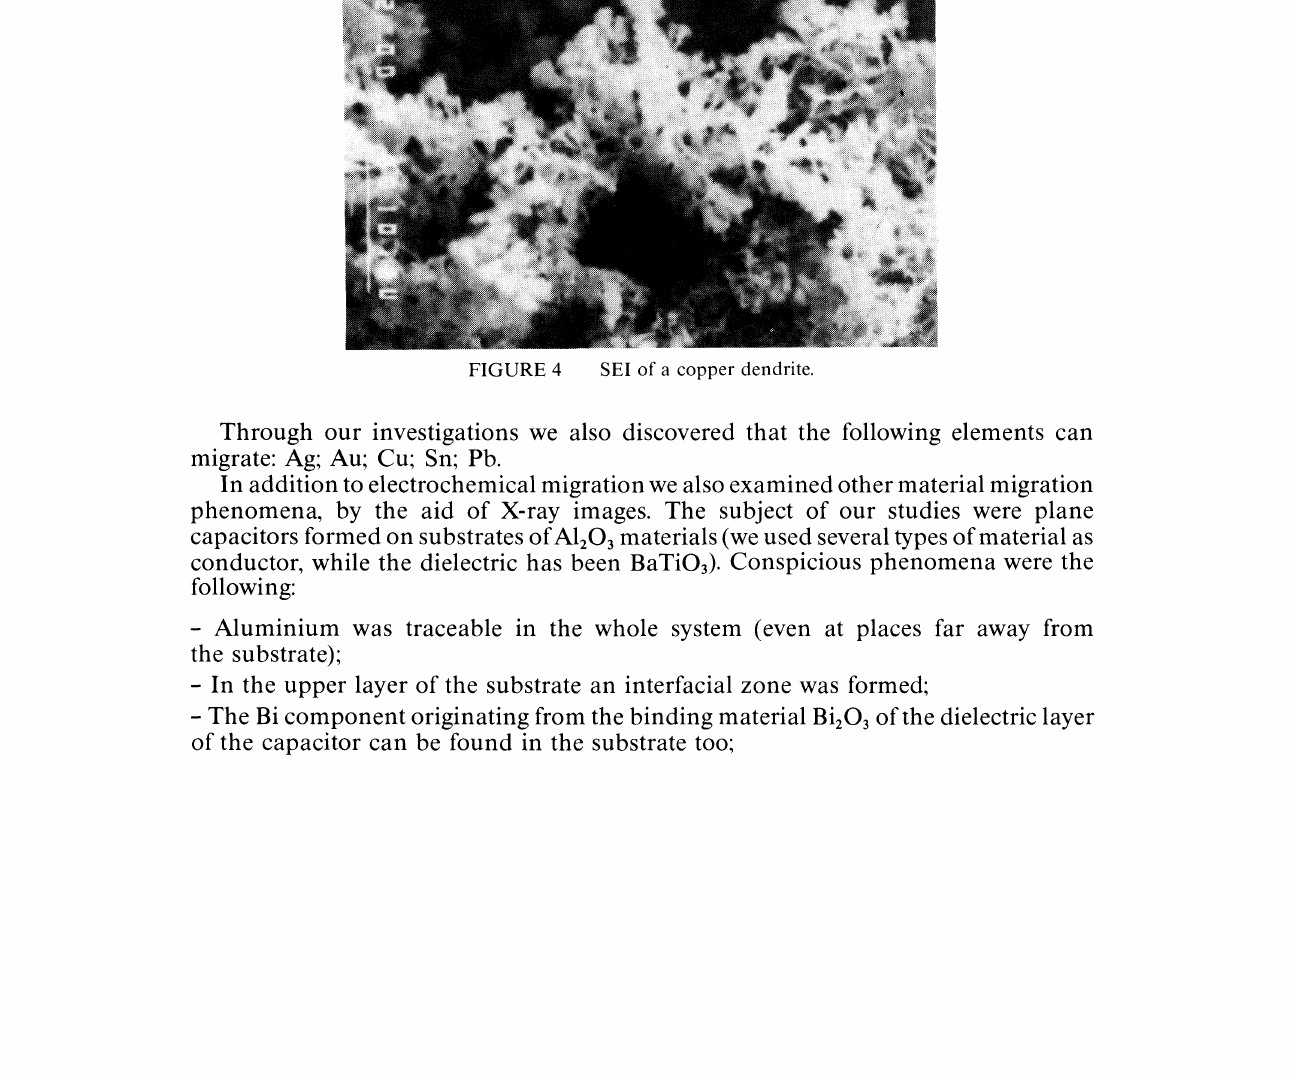
FIGURE PdL X-ray emission map.